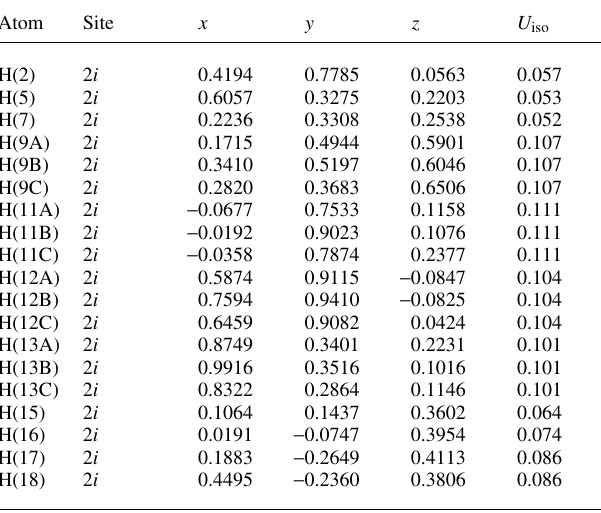
Table 2. Atomic coordinates and displacement parameters (in Å 2 )